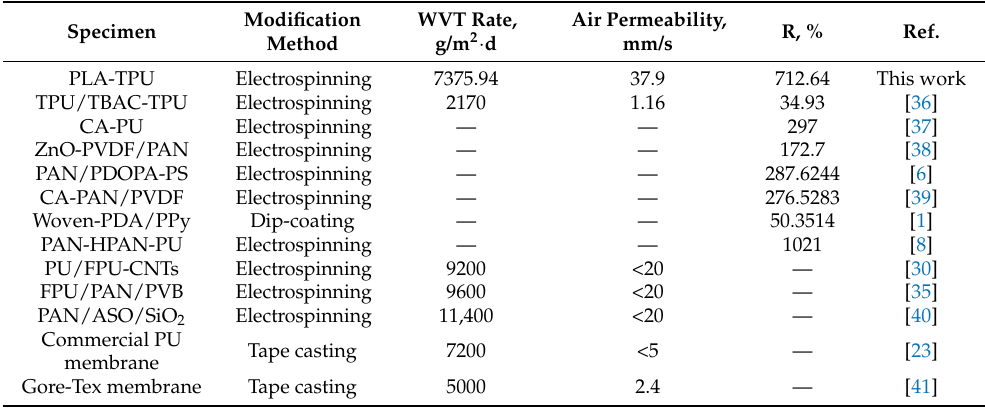
Table 1. Summary of the transport performances of this study and previous